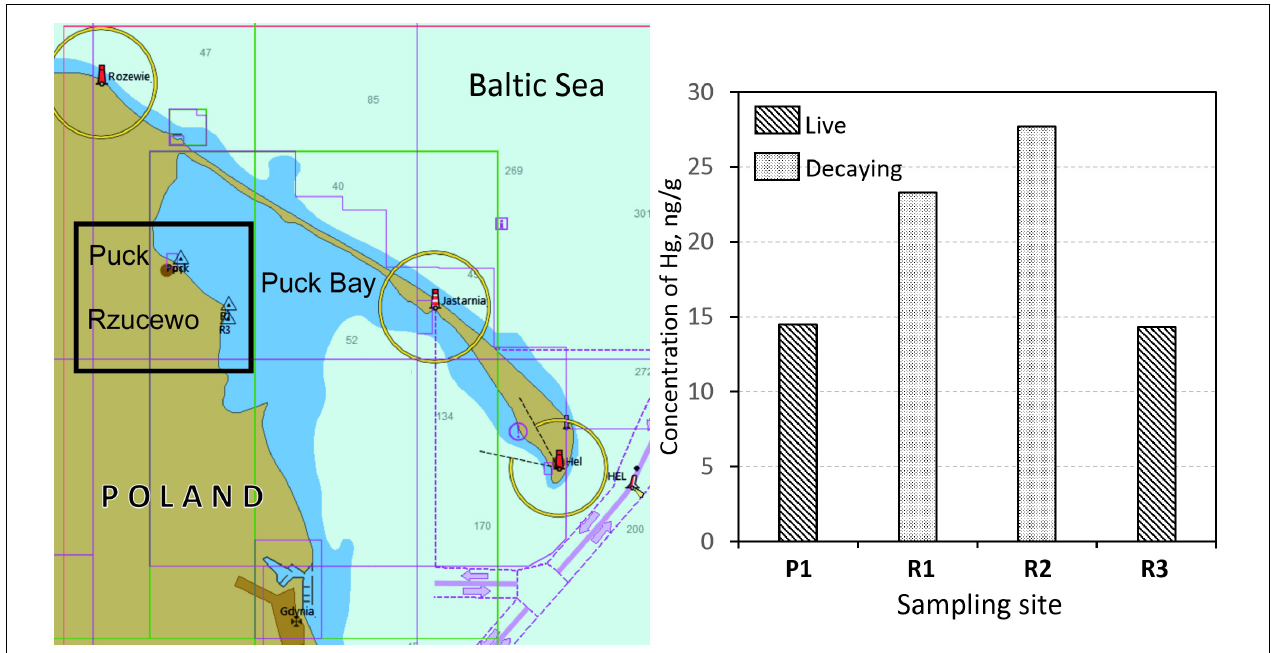
FIGURE 5 | The study area (left) and total mercury concentration (right) in live algae at the managed site (P1) and unmanaged site (R3), decaying beach wrack at the unmanaged site (R1, R2).